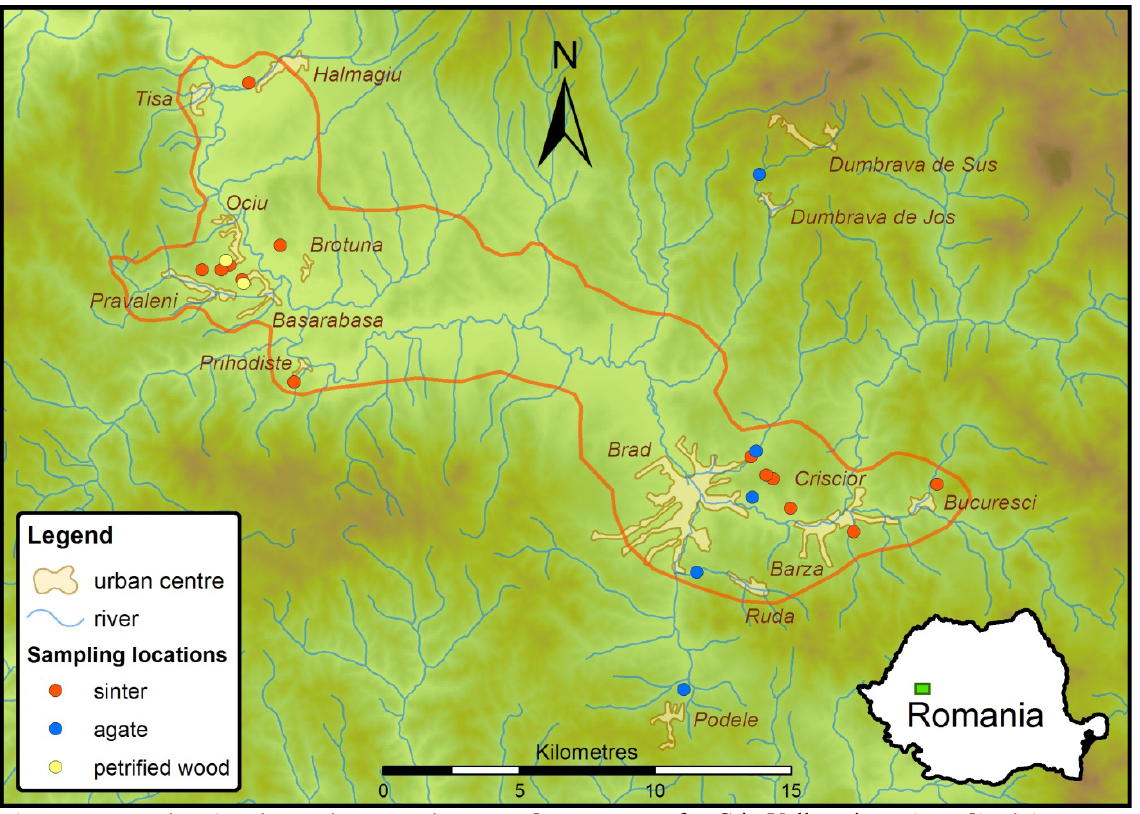
Figure 1. Map showing the study area. The general source area for Criș Valley sinter is outlined in orange. Locations where samples were collected are marked (see the legend for explanations). The inset in the lower right shows the location of the area within Romania as a green rectangle. Relief map produced from data provided by the SRTM